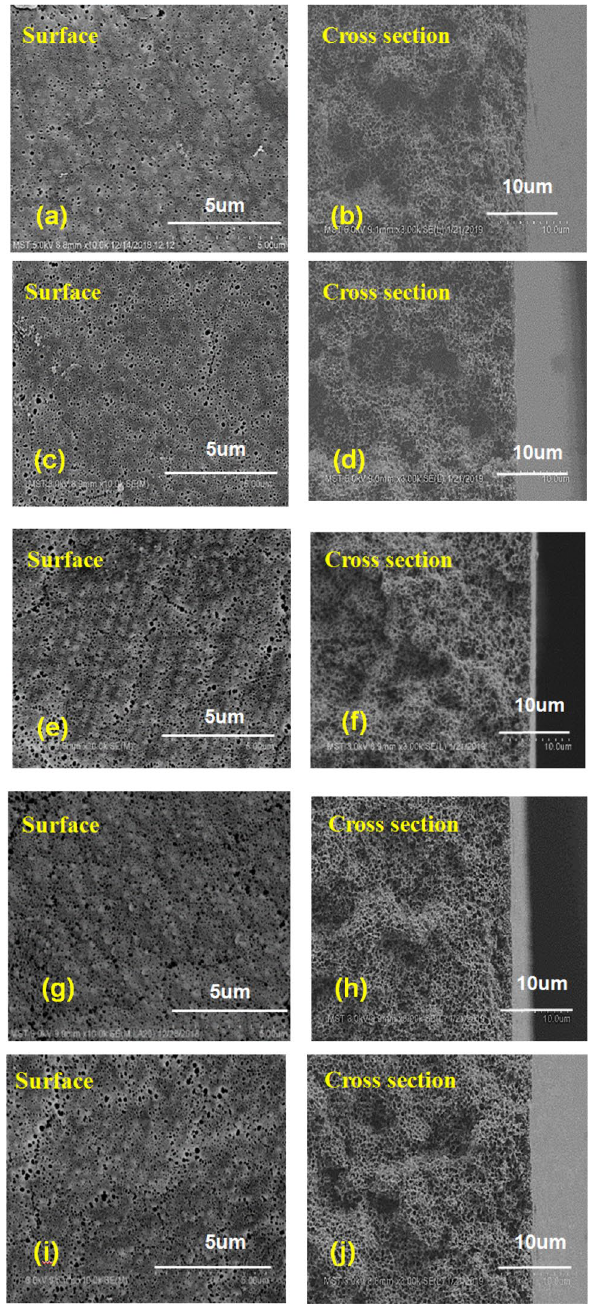
Fig. 4 The surface and cross section SEM images of PVDF mem- branes under different air gap relative humidity (room temperature, 60 wt% DMAc). Humidity: a , b 35%, c , d 50%, e, f 60%, g, h